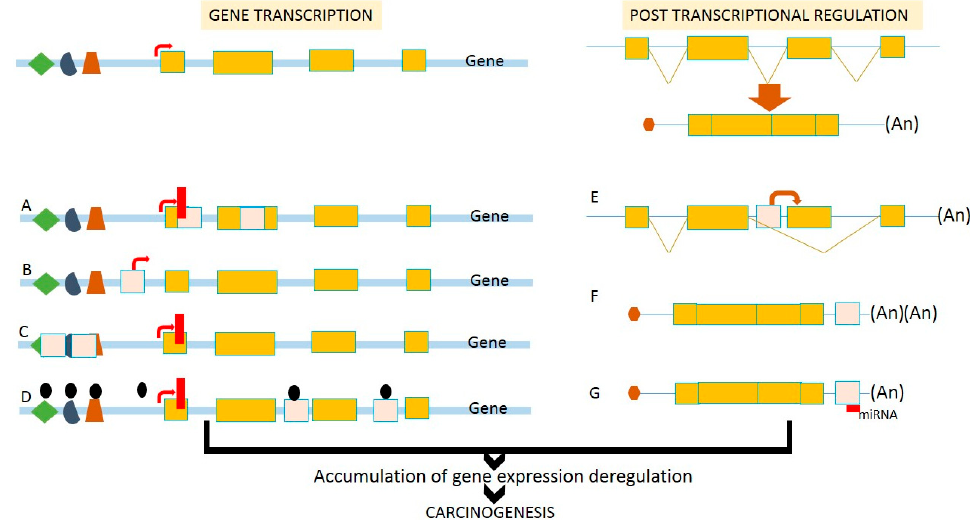
Figure 2. Effects of retrotransposition on transcriptional deregulation. Insertion of TEs into ( A ) coding region can disturb or eliminate gene functions; ( B ) upstream of the gene loci can introduce a novel alternative promoter leading to the variation of protein products; ( C ) promoter region can disrupt cis -regulatory elements, as well as transcriptional start sites; ( D ) introns can introduce epigenetic remodeling events including DNA methylation and chromatin condensation, leading to gene silencing. At the post-transcriptional step, the introduction of TEs ( E ) in the introns can cause alternative splicing that causes various protein products and functions; ( F ) at the 3 (cid:48) UTR can introduce poly-adenylation sites leading to unstable mRNAs; and ( G ) at the 3 (cid:48) -UTR can create binding sites for miRNAs and other ncRNAs. Therefore, retrotransposition affects the efficiency of gene transcription and human carcinogenesis. Table 1. TE-associated transcriptional deregulation in human cancers.